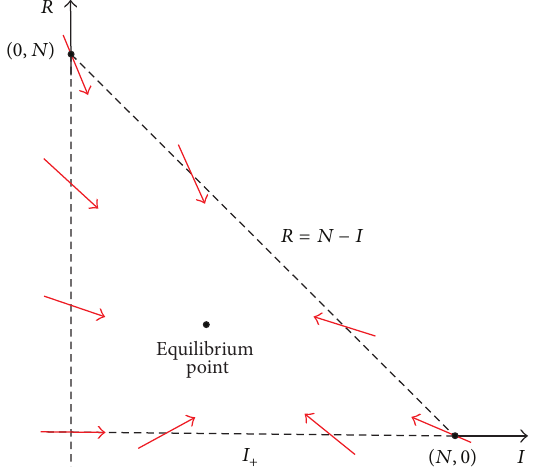
Figure 4: Trapping region bounded by the dashed line formed by the horizontal and vertical axes and the diagonal line 𝑅 = 𝑁 − 𝐼 . This triangular region contains inside the only equilibrium